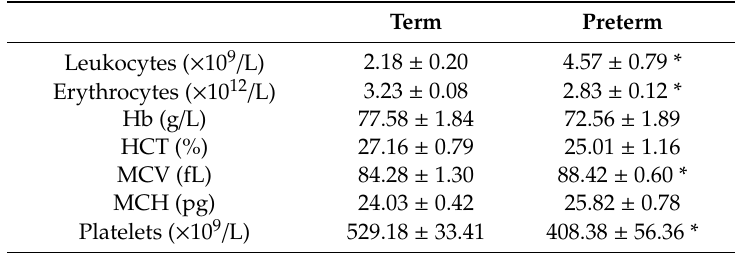
The results are expressed as a mean ± S.E.M. ( n = 10). Statistical differences: * p < 0.05 vs. term group.